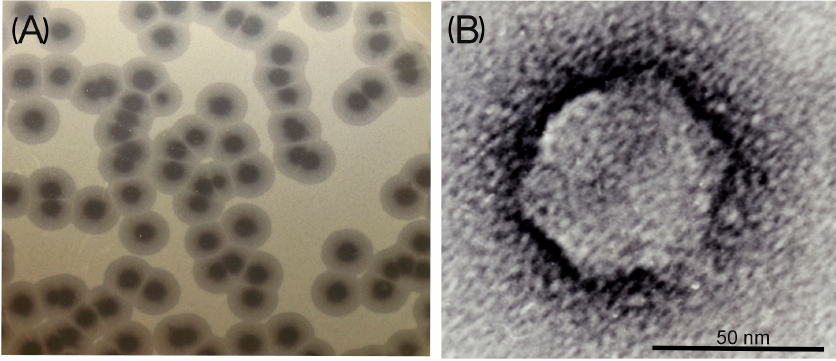
Figure 1. Morphological characteristics of phage AS11: ( A ) Phage plaques with opaque haloes on the Acinetobacter baumannii 28 ( B ) Transmission electron micrographs of the bacteriophage. Staining with 1% uranyl acetate. The scale bar is 50 nm.